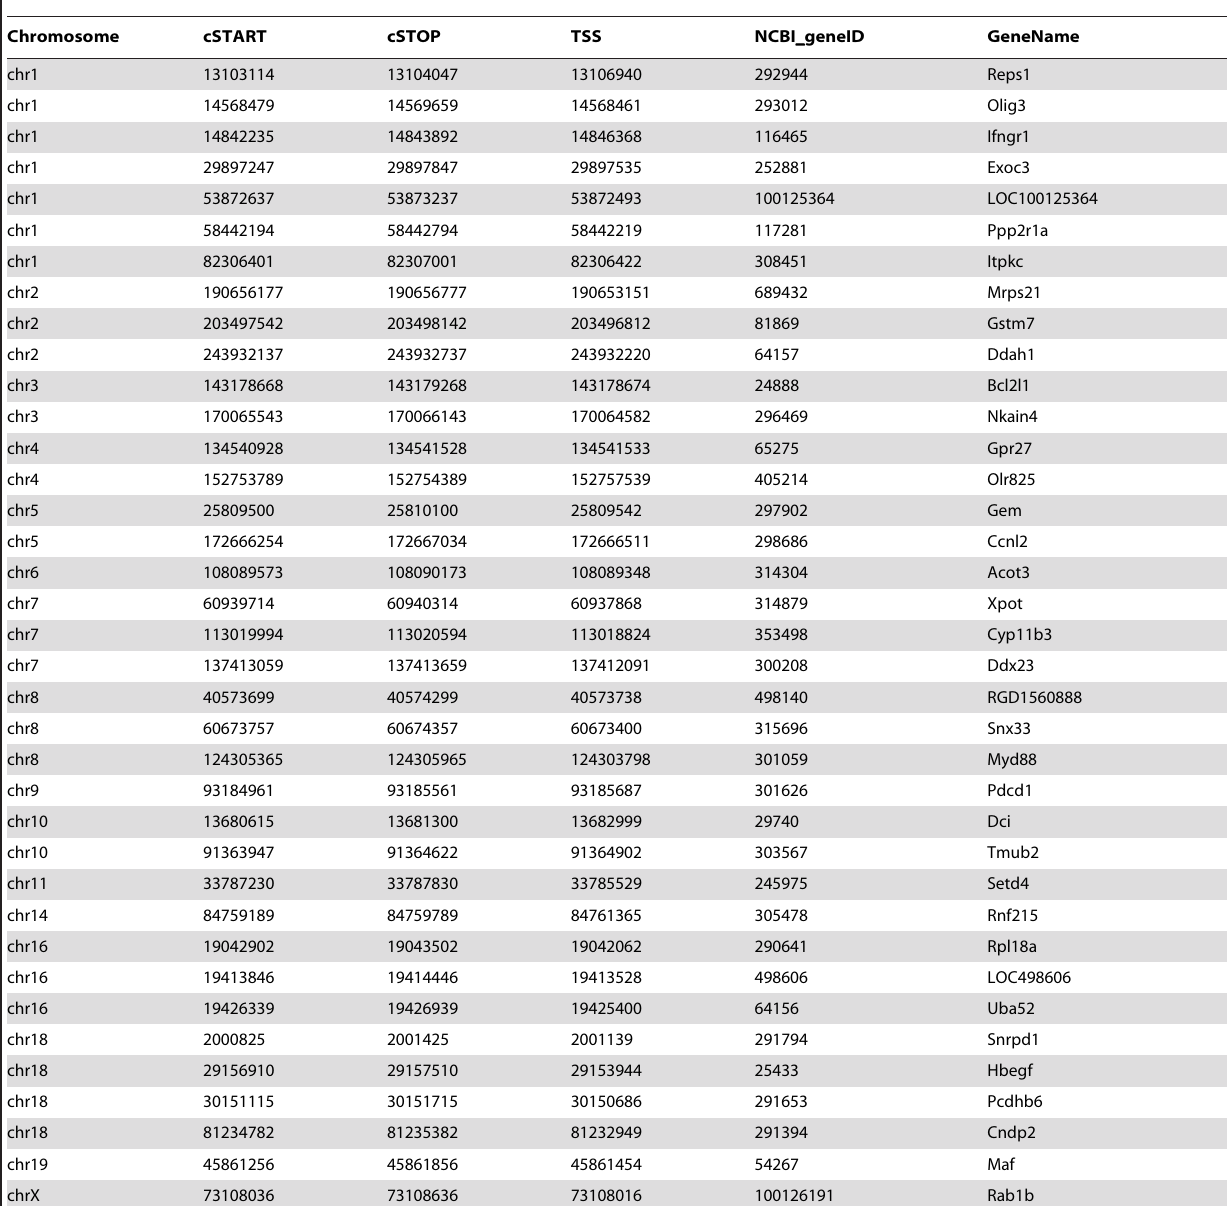
Table 1. Methoxychlor induced intersection sperm epimutations.